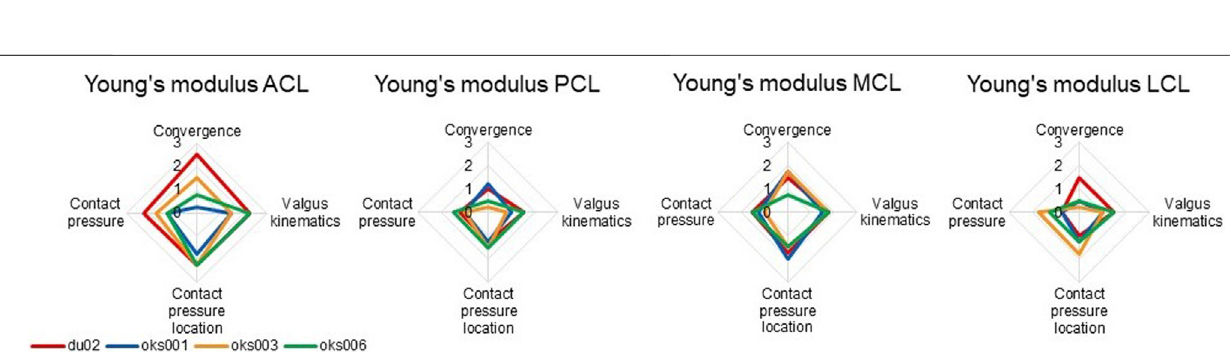
FIGURE 6 | Ligament prestretch factor sensitivity analysis simulation results rated on in fl uence on convergence, valgus kinematics, peak contact pressure, and location of peak contact pressure (0 (No in fl uence) to 3 (Large in fl uence)).